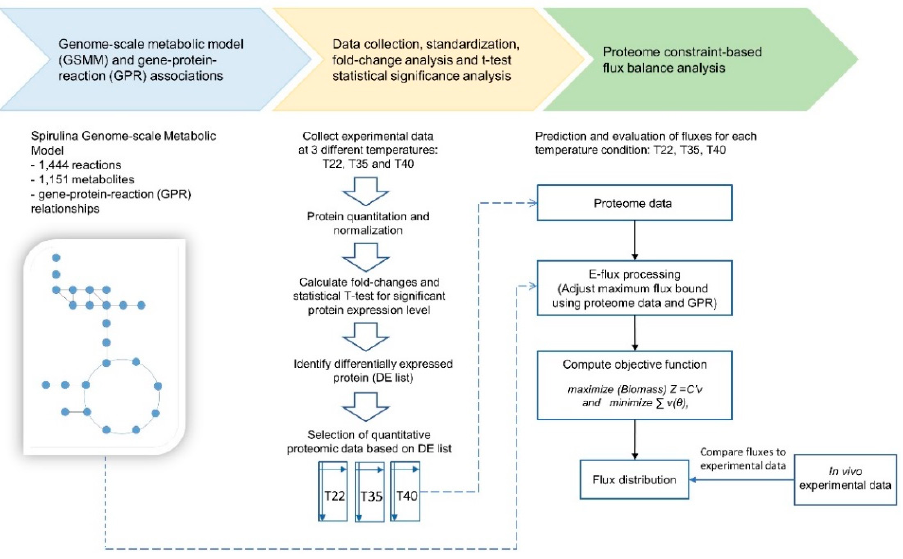
Figure 1. Workflow of the proteome-based metabolic model construction.